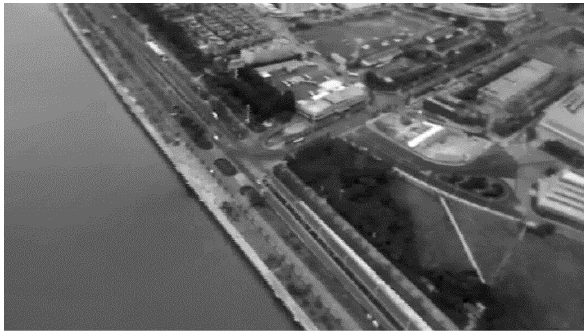
Figure 5. Mosaic result of images